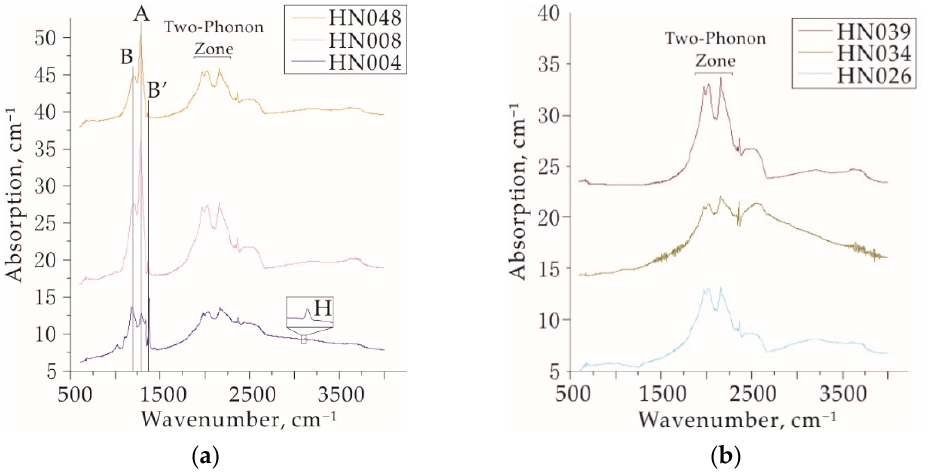
Figure 4. ( a ) IR absorption spectrum of representative type IaAB diamond samples: absorption peaks at 1,282 cm − 1 caused by A-center; absorption peaks at 1,175 cm − 1 caused by B-center; absorption peaks at 1,360–1,370 cm − 1 caused by “Platelets”(B ′ -defects); and notice the absorption peak of H at 3,107 cm − 1 for sample HN004; ( b ) IR absorption spectrum of representative type IIa diamond samples.